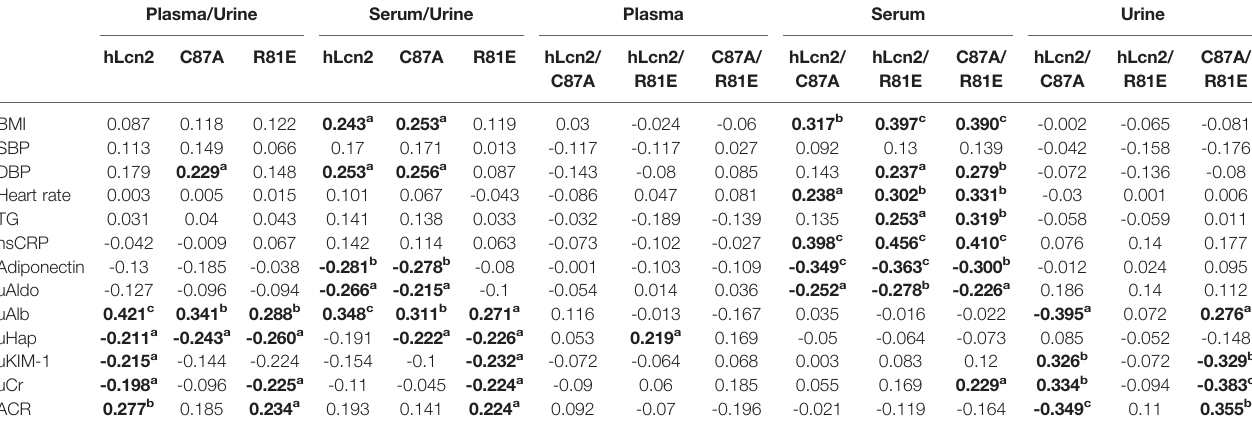
TABLE 5 | Correlations between the LCN2 variants ratios and cardiometabolic risk factors and renal function. Plasma/Urine Serum/Urine Plasma Serum